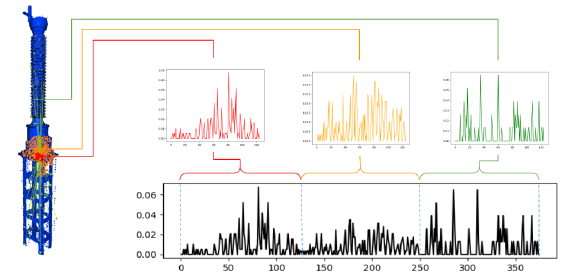
Figure 8. Multi scale neighbours for computing our feature on a keypoint with three radii and 5 3 bins per